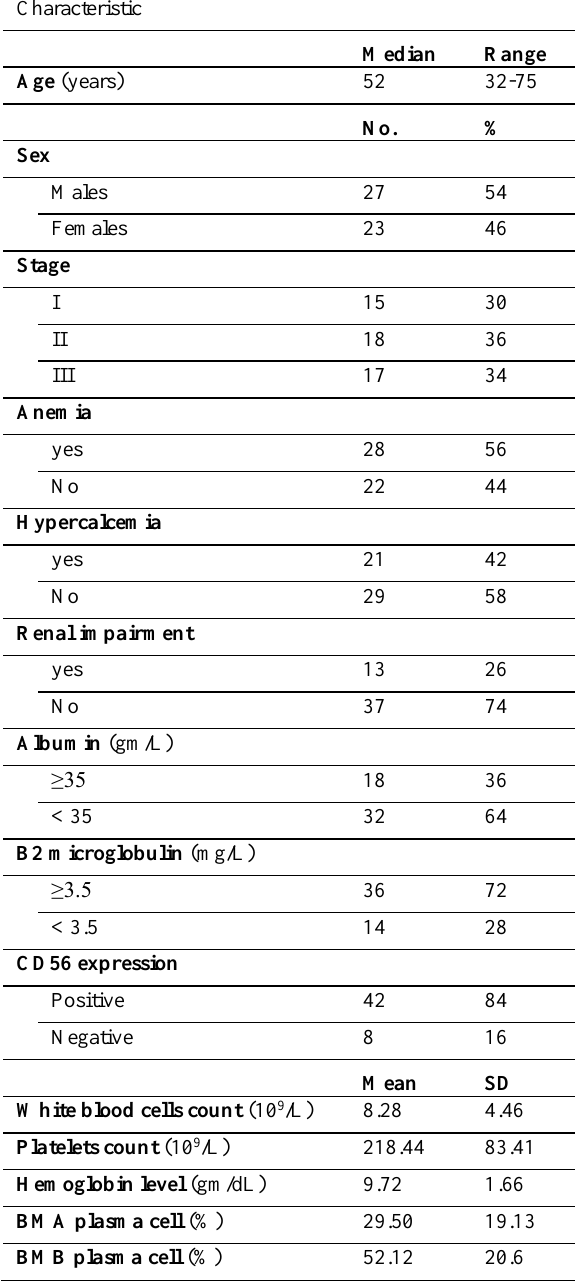
Table 1: Demographics and baseline characteristics of 50 patients with multiple myeloma